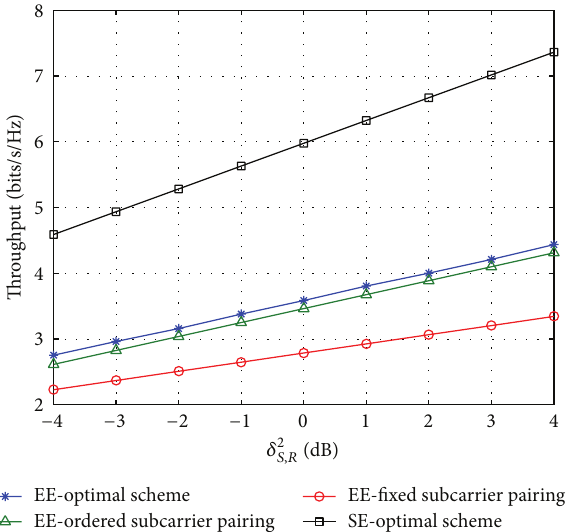
Figure 6: Throughput versus channel variance of 𝑆 → 𝑅 link with 𝑁 = 2 relays, and 𝑤